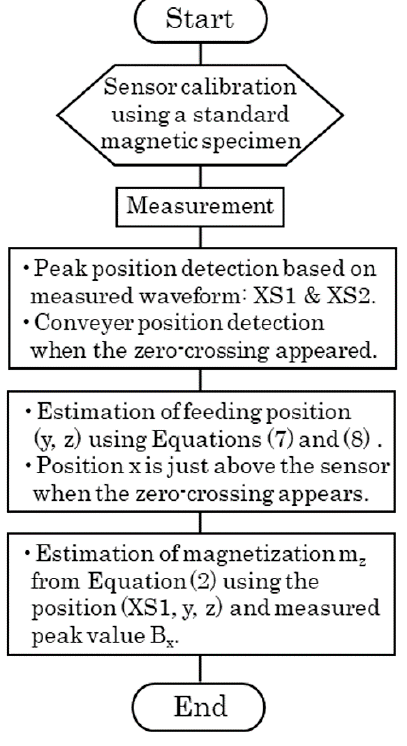
Figure 9. Flow chart of the proposed position estimation method.